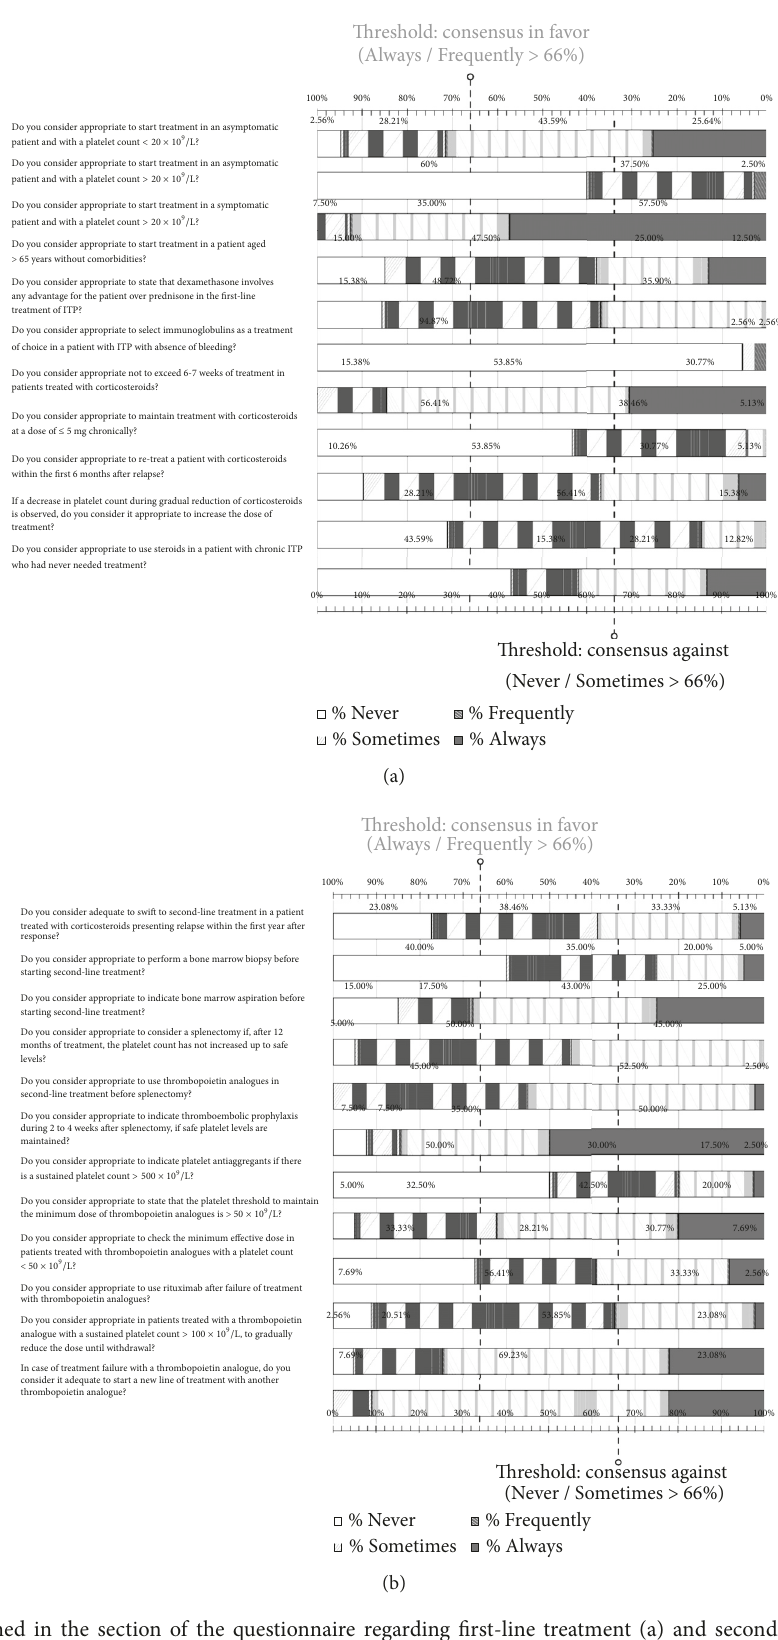
Figure 2: Results obtained in the section of the questionnaire regarding first-line treatment (a) and second-line treatment (b) of ITP. Distribution of the percentages of